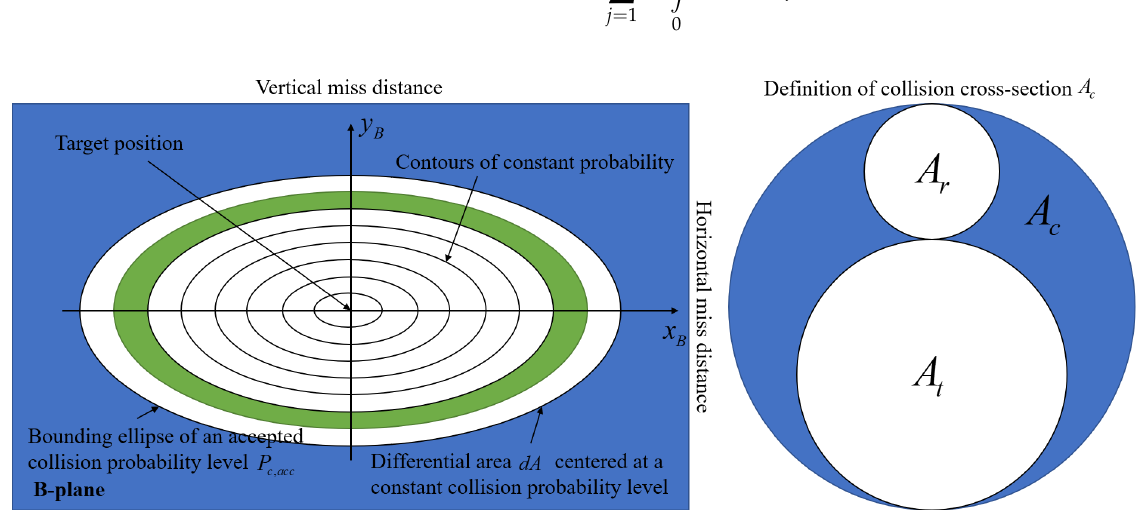
Figure 4. Illustration of the concept of collision risk estimation based on the integration of statistical object fluxes over a collision probability density function in the b − plane centered on the target object.